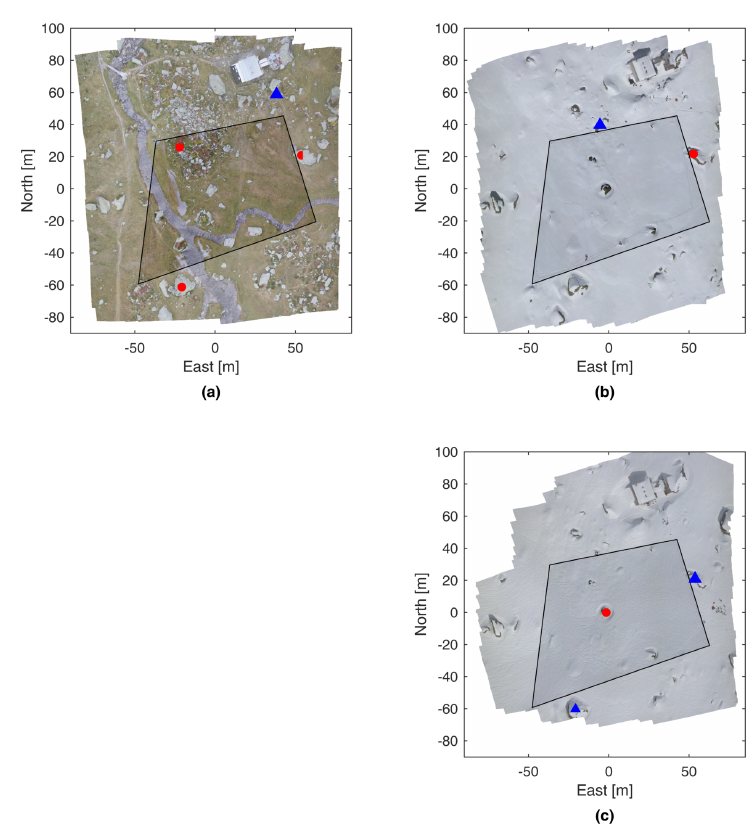
Figure 1. Topography of the surveyed area during summer 2016 (( a ), top-left), winter 2016 (( b ), top-right) and winter 2017 (( c ), bottom-right). The boundaries of the study area are in black. Red dots denote the station points of the MultiStation, whereas the blue triangle represents the point used as angular reference. No bare-soil survey was performed during summer